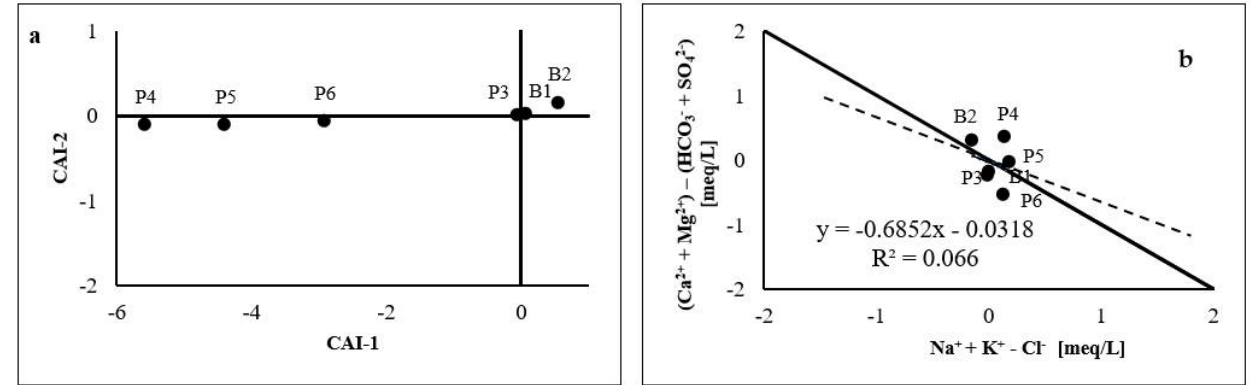
Figure 6. Bivariate diagrams for cation exchange. ( a ) CAI-2 versus CAI-1 correlation diagram; ( b ) basis exchange process diagram.